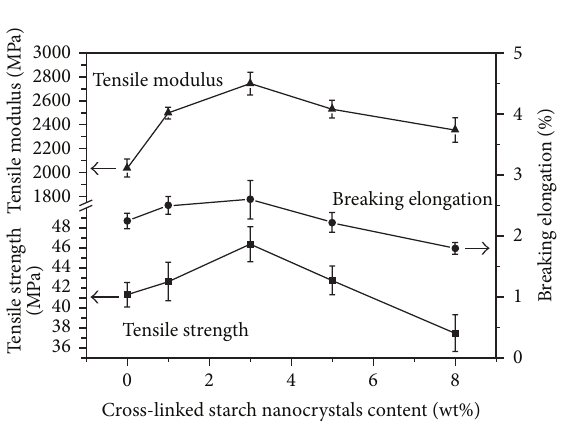
Figure 5: DSC thermograms of CStN/PLA nanocomposites and PLA